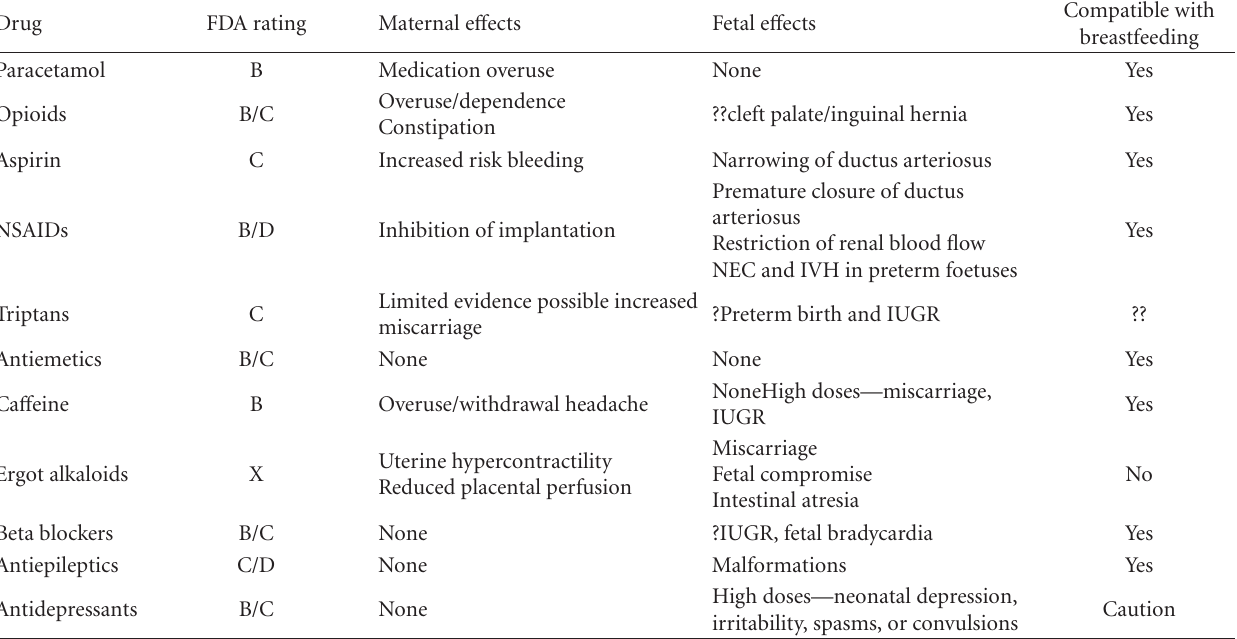
Table 2: Drugs commonly used for treatment and/or prophylaxis of migraine and their FDA rating and fetomaternal e ff ects.